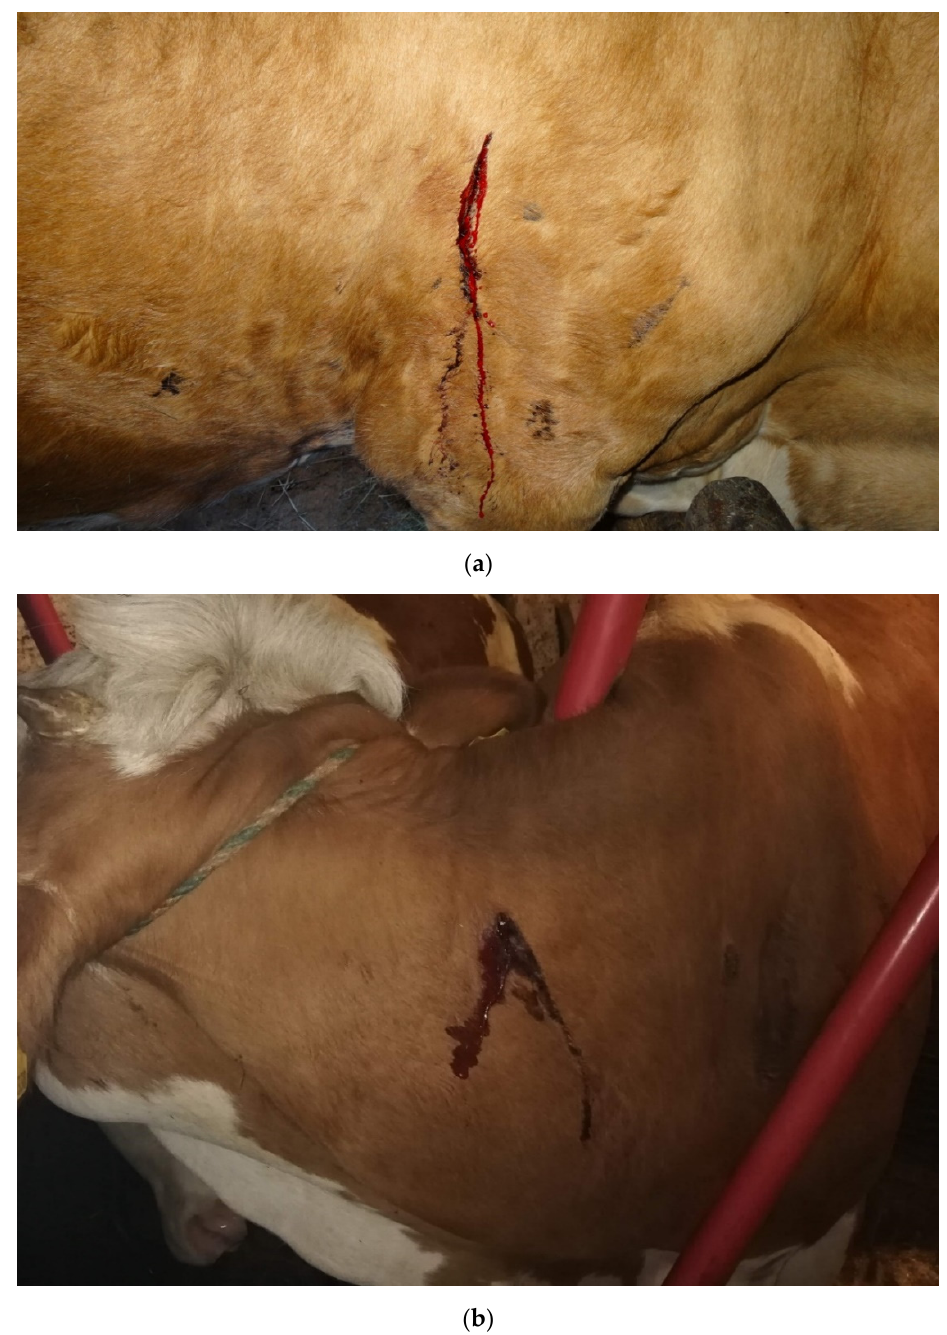
Figure 1. Cattle affected by P. bovicola with bleeding spots on ( a ) the thorax in the shoulder region and ( b ) the neck. Photo credit: Susanne Möser ( a ), Johannes Reithofer ( b ).